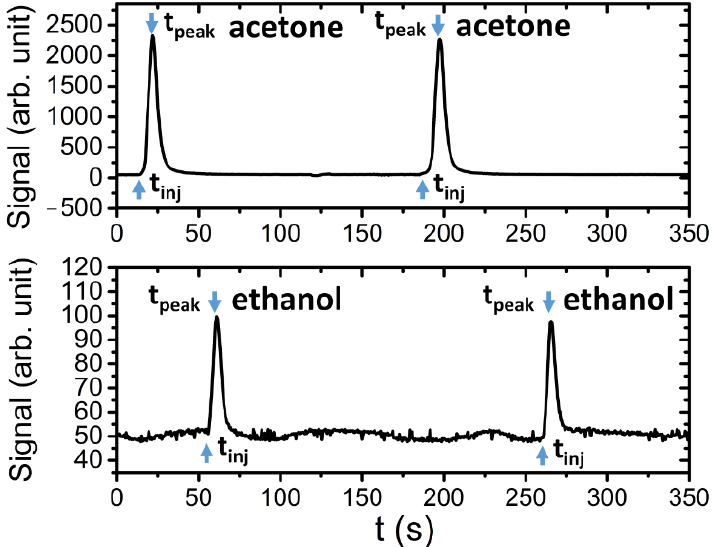
Figure 8. Example of peaks detected for ethanol and acetone.